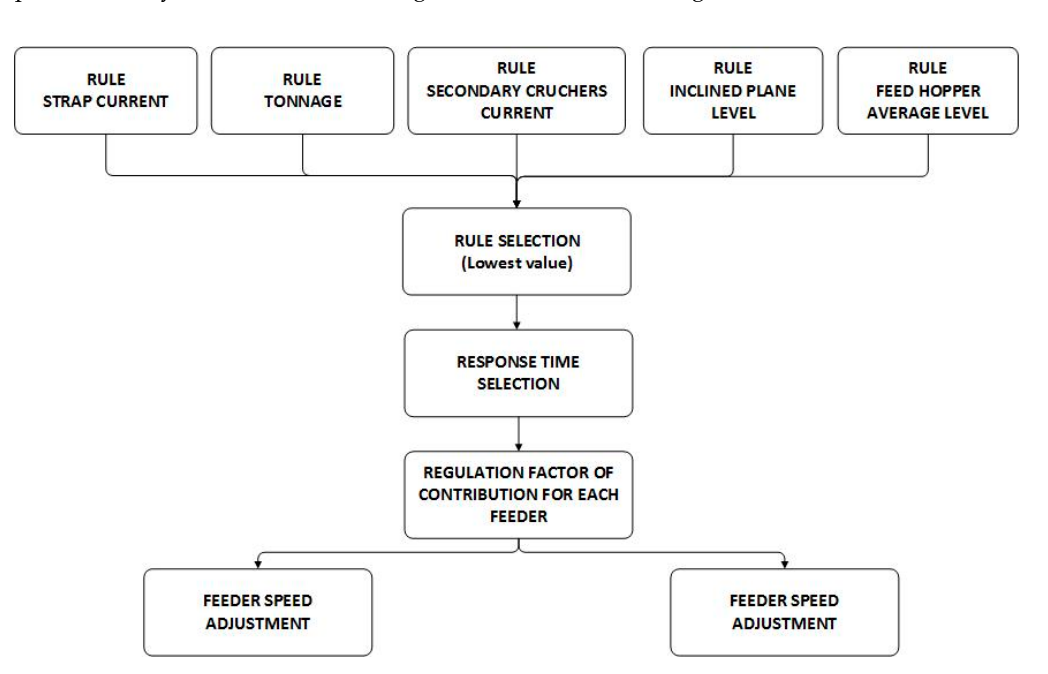
Figure 1. Expert System K-UCN, Secondary Crusher.